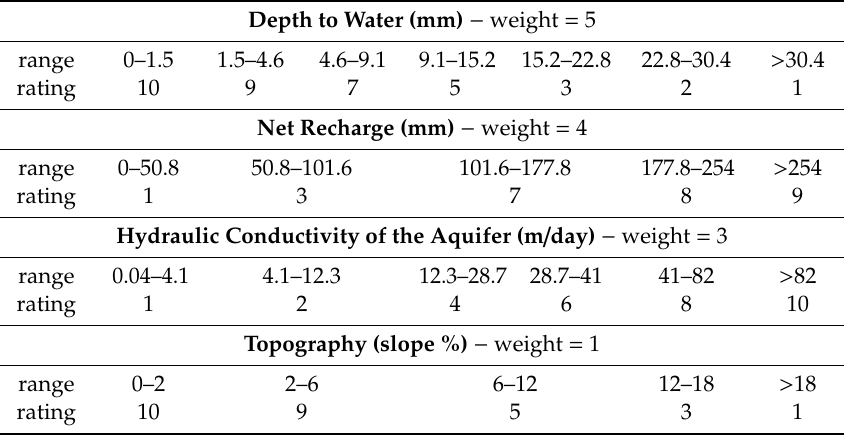
Table 2. DRASTIC D, R, T, and C rating and weighting